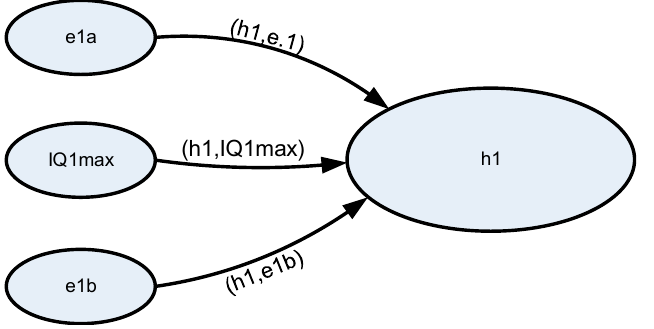
Figure 9. Model for the indirect hypothesis h2.